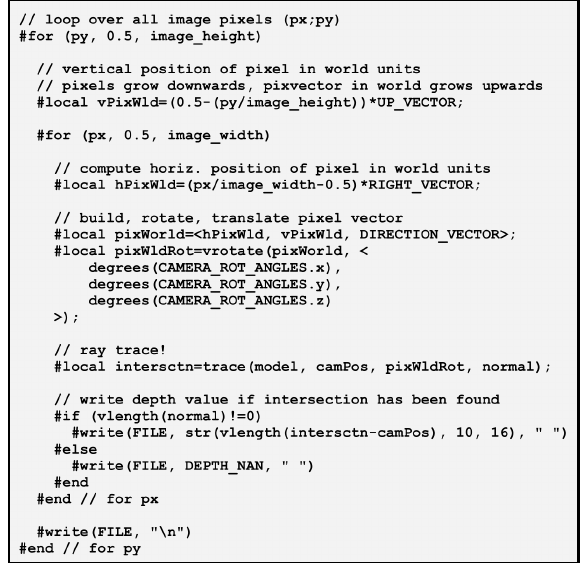
Figure 4. POV-Ray code snippet to create ASCII depth